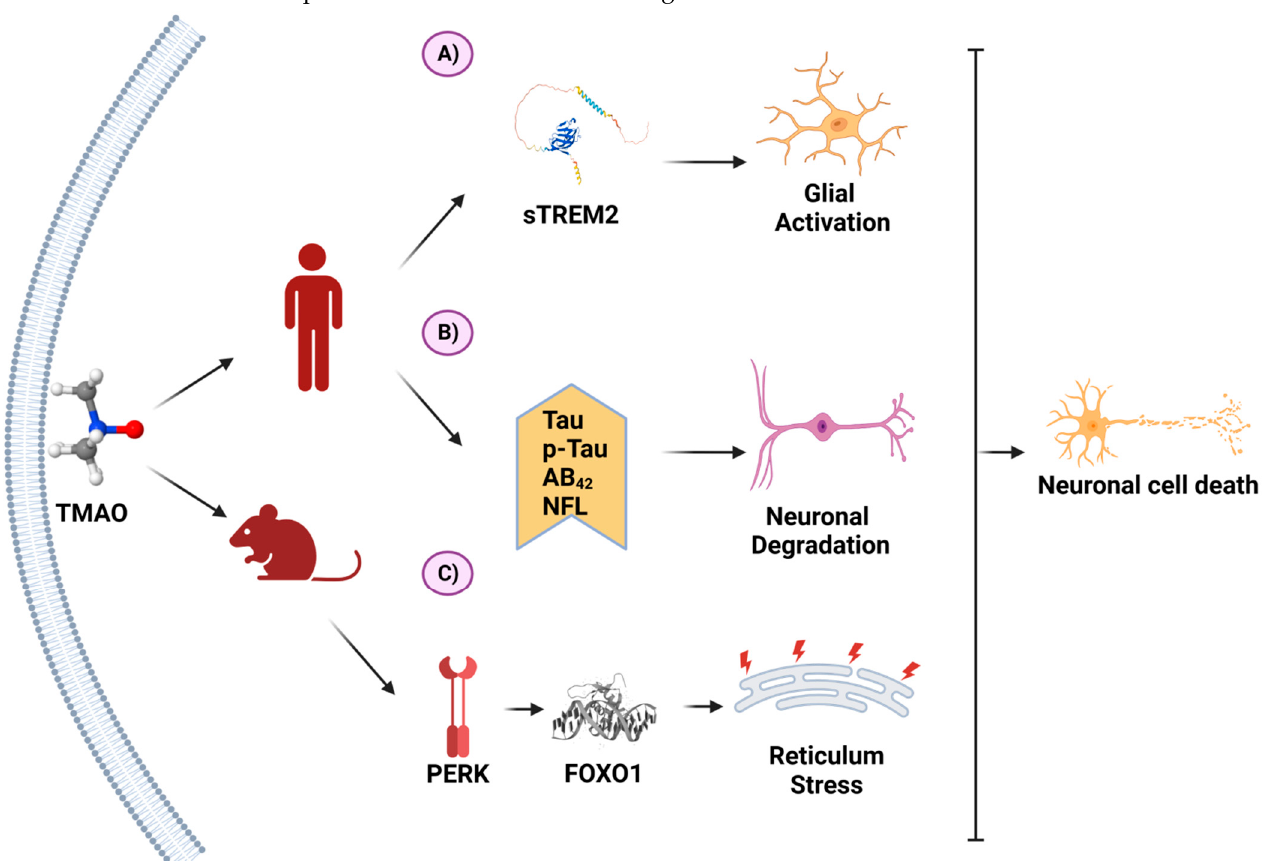
Figure 4. TMAO and its molecular mechanisms in neurons. ( A ) In a clinical study on patients with Alzheimer’s disease (AD), TMAO was positively associated with sTREM2, a biomarker for glial activation. ( B ) In another clinical study on AD, TMAO was associated with higher levels of AD biomarkers. ( C ) In an animal model of AD, TMAO induced the unfolding protein response through PERK activation, inducing endoplasmic reticulum stress. These processes favor neuron degeneration and death. (Created with BioRender.com.).